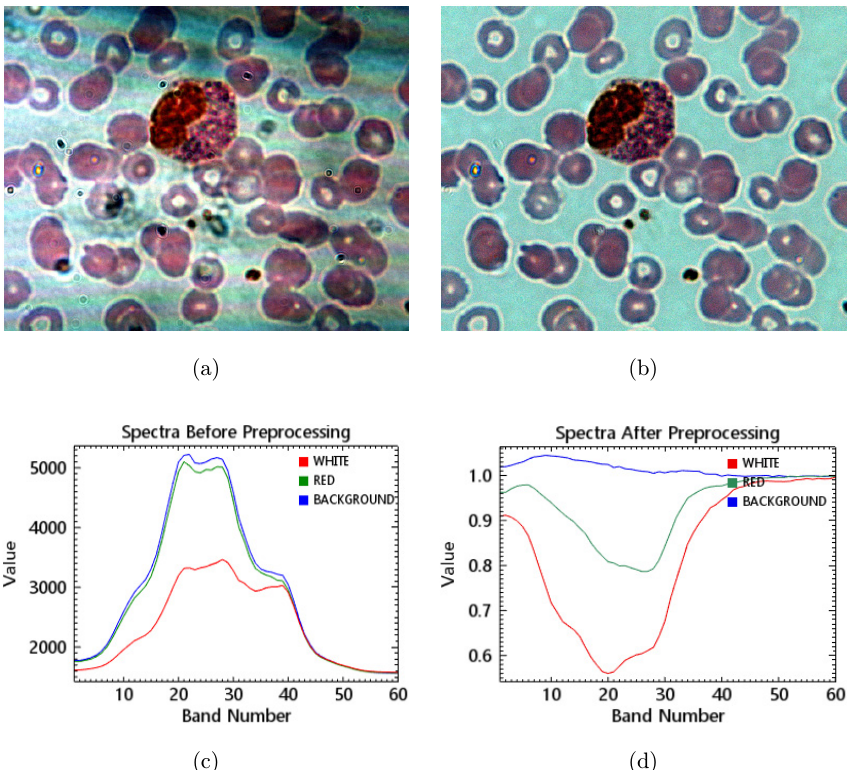
Fig. 3. (a), (b) Original and preprocessed eosinophil hyperspectral images. (c), (d) Spectra of original and preprocessed eosinophil hyperspectral